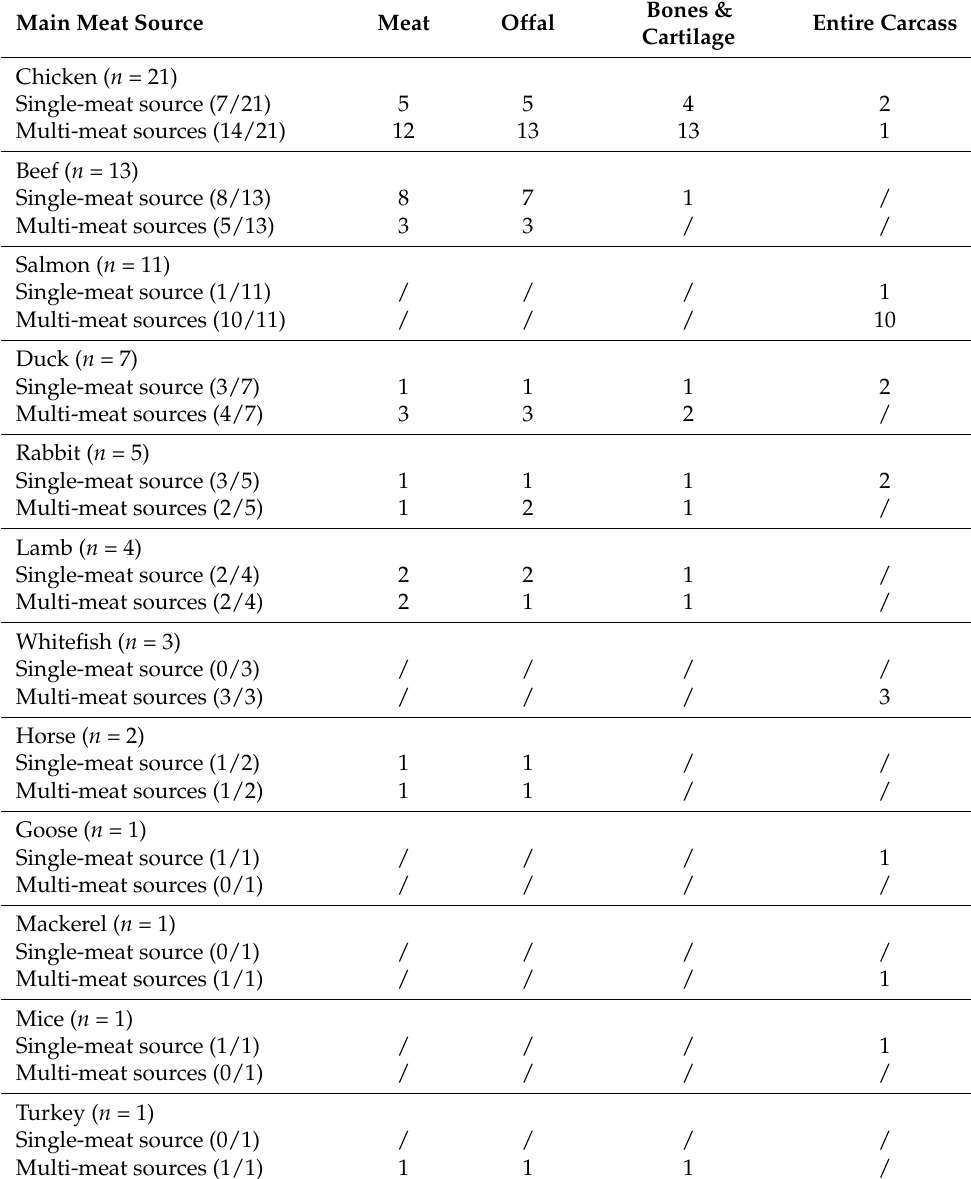
Table 2. Meat and animal by-products sources in RMBDs ( n =